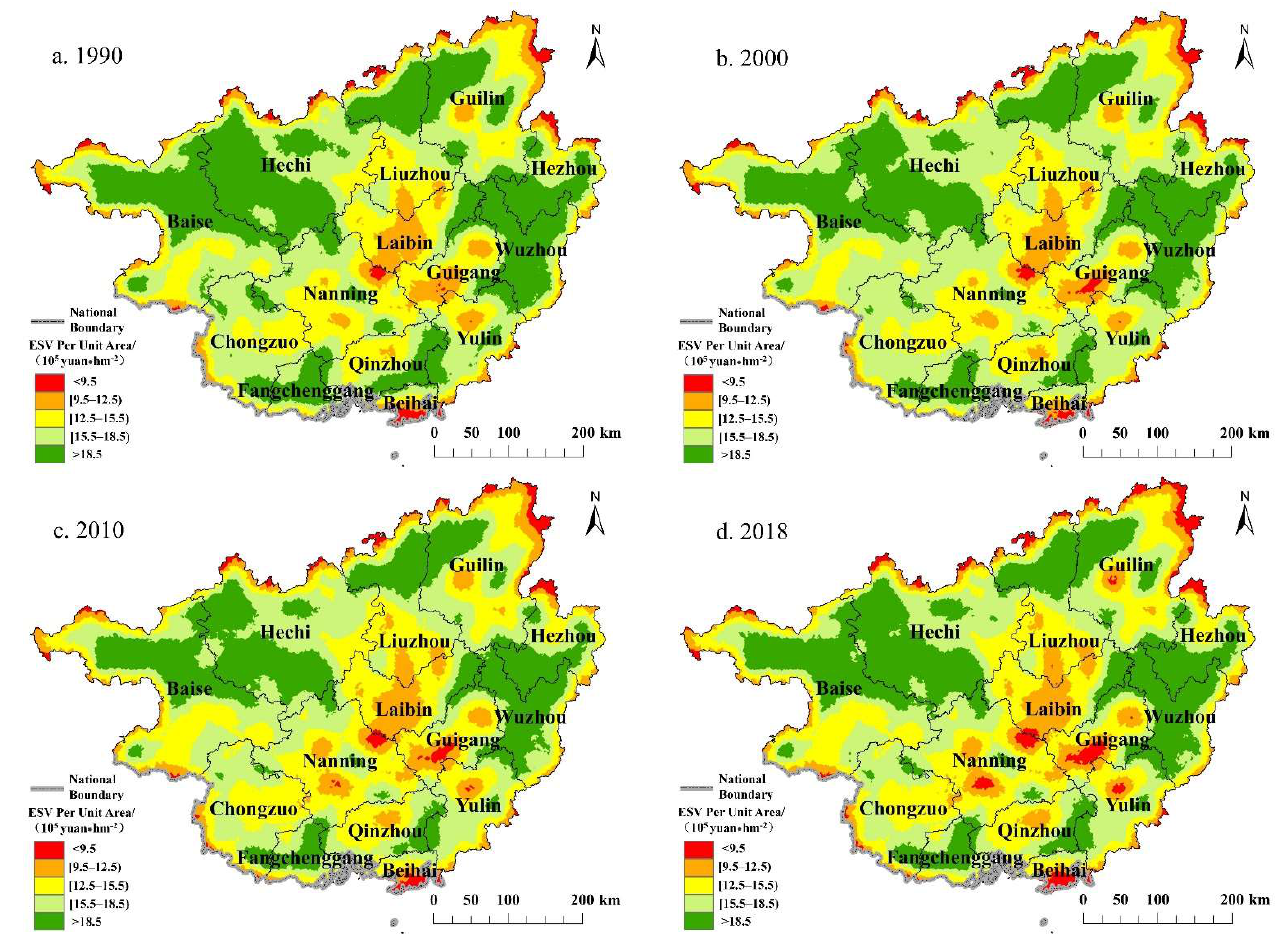
Figure 6. Spatial distribution of total ESV per unit area of Guangxi in 1990 and 2018. In general, the most striking spatial characteristic was that the high ESVs were mainly distributed in the surrounding mountainous area and low in the central plain area. Specifically, the area of the highest-value and high-value zones of ESVs shrank, while the area of medium-value and low-value zones was gradually increasing, among which the total area of the high-value zone reached 53%, yet the area of the highest-value, medium-value and low-value zones accounted for a relatively small proportion. Spatially, the high-value zone of ESV per ha contained Guilin, Hechi and other northern cities, as well as Hezhou, Yulin and other southeast cities as its core regions, showing a strip layout; the southern cities located in the central basin, such as Nanning, Laibin, Guigang and Beihai mainly belonged to the low-value and medium-value zones, showing a dotted layout; the highest-value zone was mainly distributed in the surrounding hilly areas covered with forest, grass, etc., with high ecological functions. Since the 21st century, the difference of the spatial distribution of ESV has become more complicated. Accompanied with land consolidation, coastal aquaculture and urbanization, a large number of highest-value zones have transferred to high-value and medium-value zones, especially in Hechi, Fangchenggang and northern Guilin, while the areas of medium-value and low-value zones in Laibin, Guigang, Nanning and Beihai increased significantly. The area of highest-value zones and high-value zones that turned into medium-value and low-value zones was much larger than the area of the low-value zones that switched to high-value zones, which indicates that the overall ecological service function was